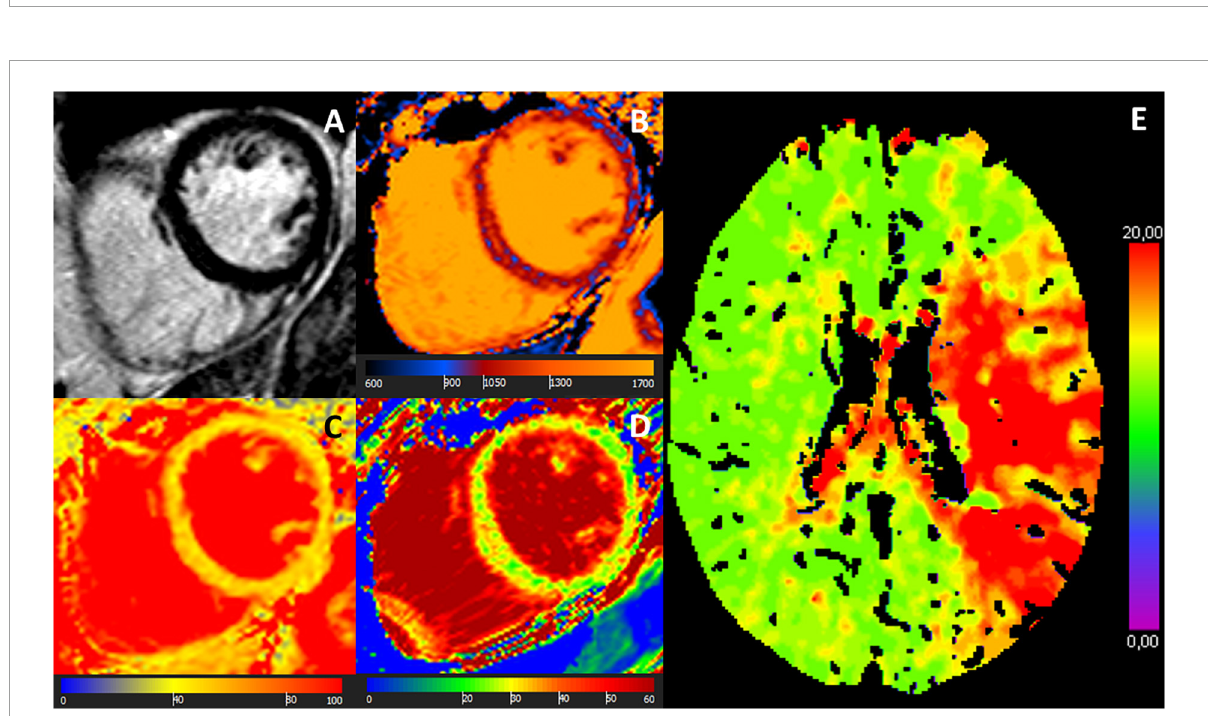
FIGURE3 MR images of a 68-year-old female with troponin-positive ischemic stroke and unobstructed coronary arteries. (A) LGE-negative, (B) increased T1 (1,074 ms), (C) increased T2 (52 ms), (D) increased ECV (30%) in an identical midventricular short-axis slice. (E) Cerebral volume perfusion CT at admission showed prolonged time-to-peak perfusion in the territory of the acute occluded left middle cerebral artery (red